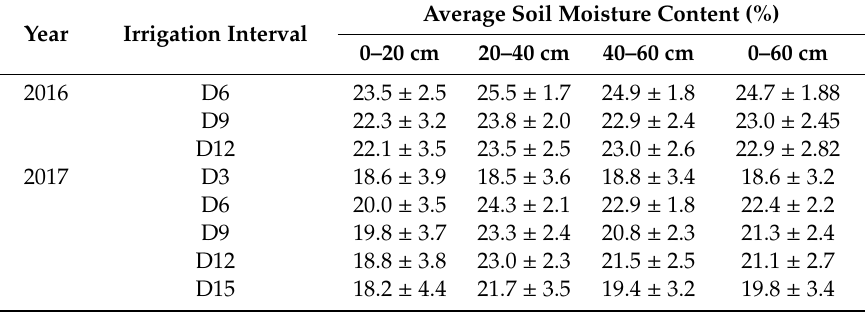
Table 4. Changes in the average soil moisture content of various soil layers during the irrigation period under different irrigation intervals.